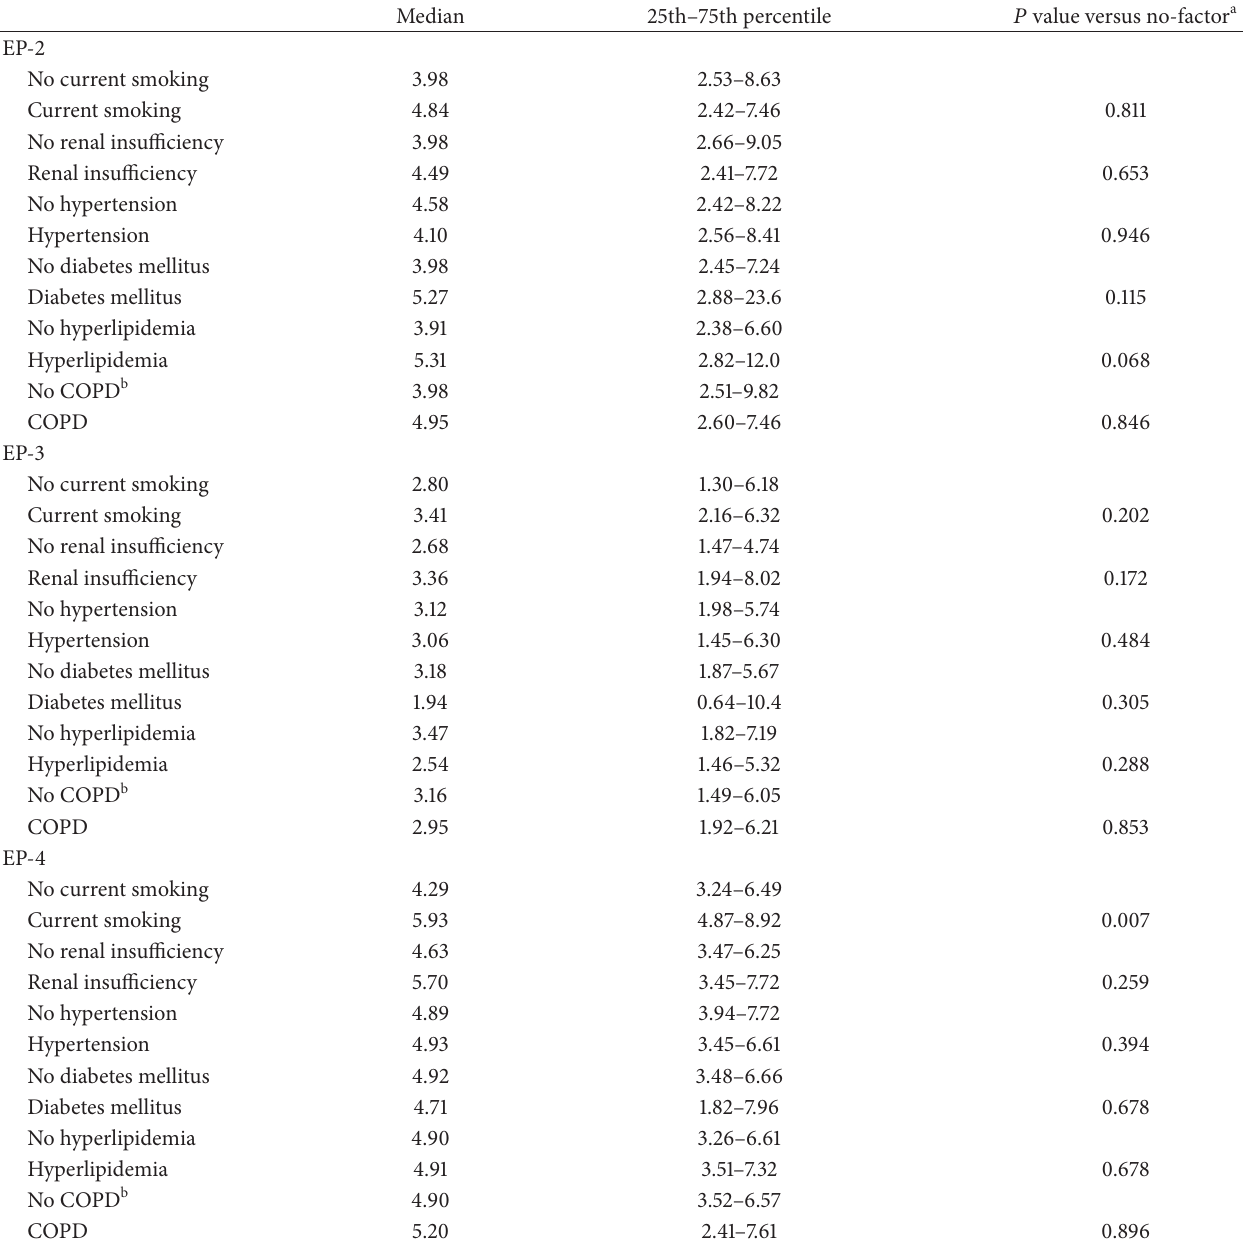
Table 5: Transcript levels of PGE receptors in the AAA samples stratified by cardiovascular risk factors. The number of patients in every group is indicated in Table 1. Data are expressed as relative to 𝛽 -actin